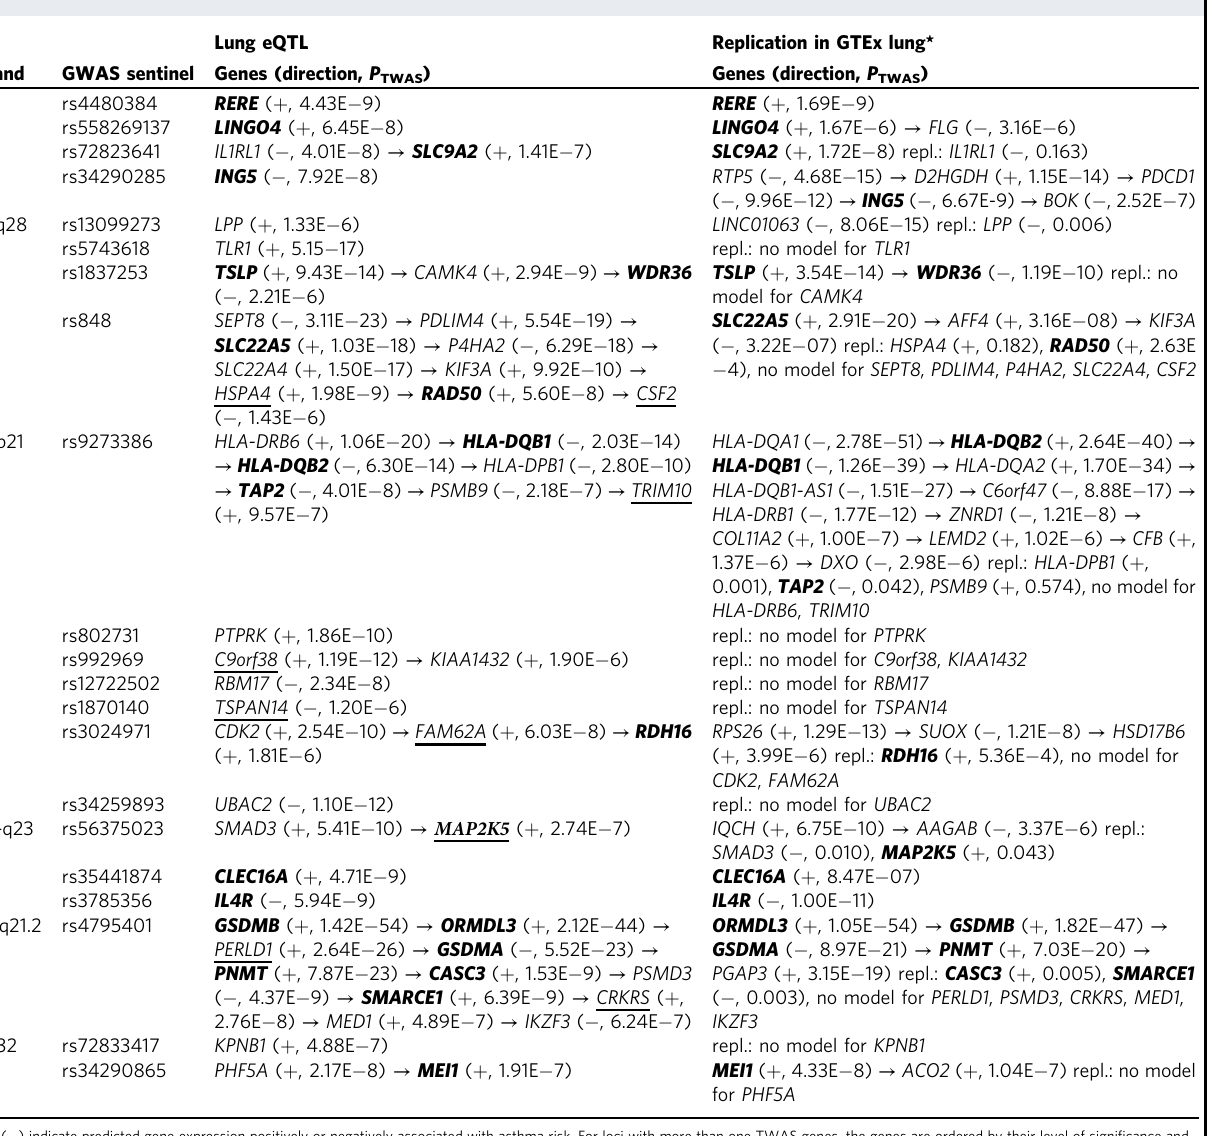
( + ) and ( − ) indicate predicted gene expression positively or negatively associated with asthma risk. For loci with more than one TWAS genes, the genes are ordered by their level of signi fi cance and separated by arrows. In bold are lung TWAS genes that replicated in GTEx lung. Underlined are lung TWAS genes not reported in previous asthma GWAS. *AllBonferroni-correctedTWASgenesperlocifoundinGTExlungareindicatedaswellastheresultsofTWASgenesidenti fi edinthelungeQTLdatasetinordertoseekforreplication( P TWAS <0.05)in GTEx